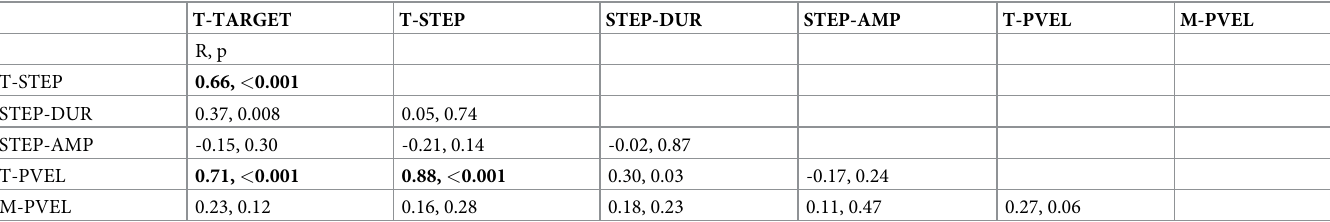
Table 4. Correlations between sequence-specific learning effects of all movement parameters for the group of all participants in Experiment 2.